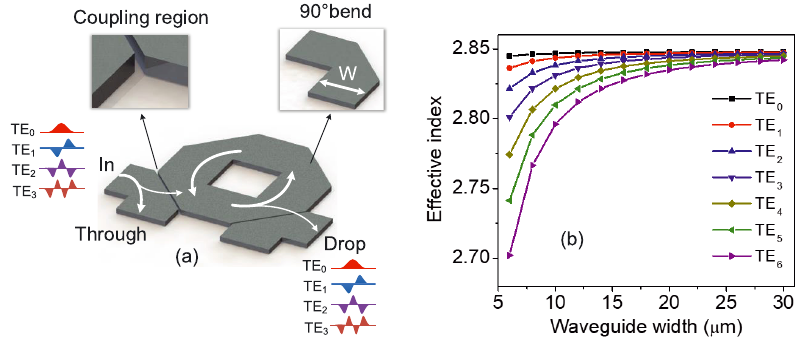
Figure 1: (a) Schematics of the multi-mode ring resonator. (b) Calculated effective indices for TE 0 – TE 6 modes with different waveguide widths at 1550